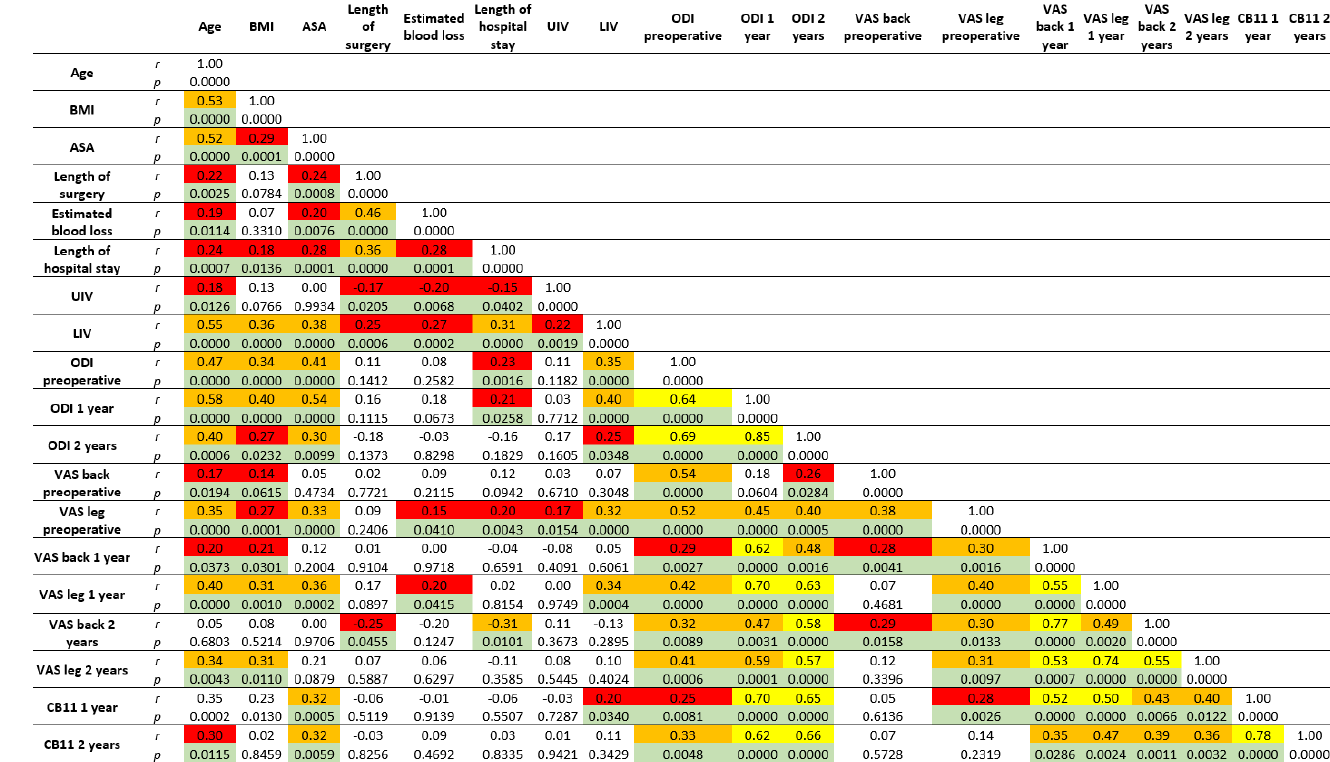
Figure 2. Overview of all the observed correlations among the considered parameters. Red, orange and yellow color indicate significant weak, moderate and strong correlations, respectively.